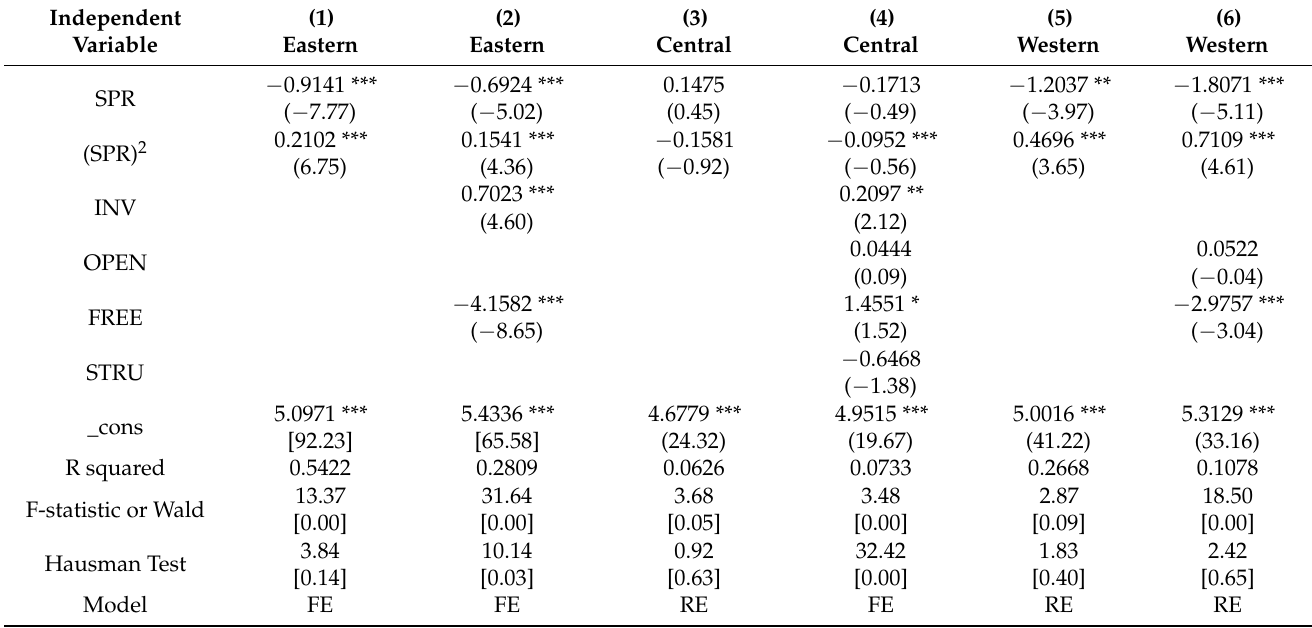
Table 5. Estimation results of subgroups categorized by